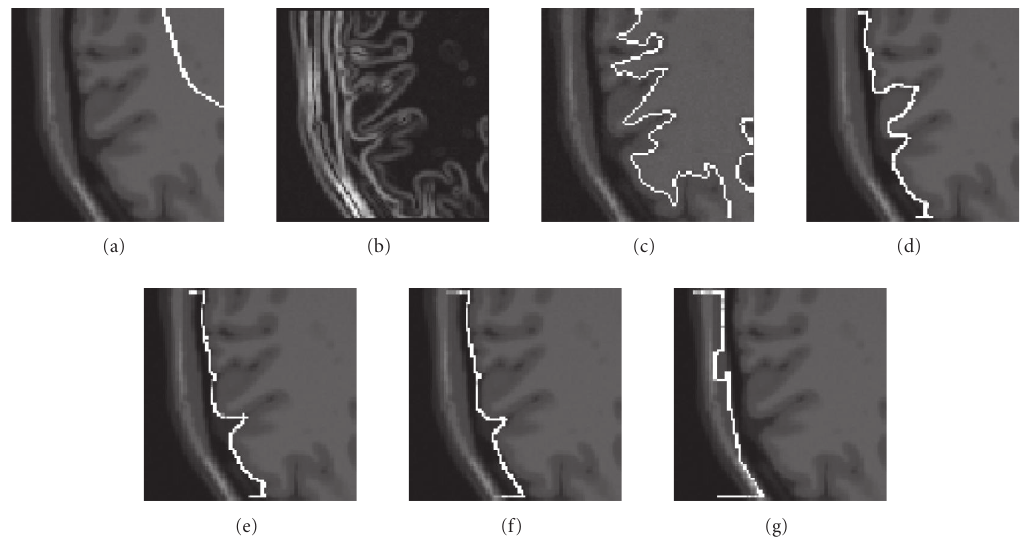
Figure 3: By choosing active regions with di ff erent sizes, the dual-front active contour model may achieve di ff erent global minima related to di ff erent active regions and iteration times. (a) The original image with the initialization. (b) The corresponding gradient information. (c) Segmentation result using a 5 × 5 structuring element with 15 iterations of morphological dilation. (d) Segmentation result using a 7 × 7 structuring element with 15 iterations of morphological dilation. (e) Segmentation result using an 11 × 11 structuring element with 15 iterations of morphological dilation. (f) Segmentation result using a 15 × 15 structuring element with 15 iterations of morphological dilation. (g) Segmentation result using a 23 × 23 structuring element with 15 iterations of morphological dilation.